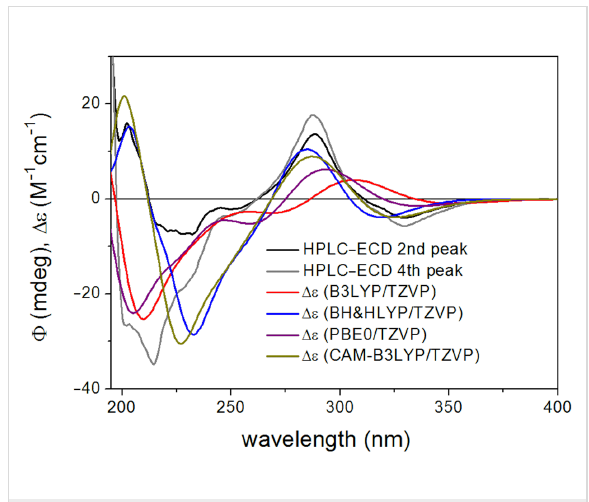
Figure 8: Experimental HPLC–ECD spectra of (2 R ,5’’ S )- 2a and (2 R ,5’’ R )- 2d compared with the Boltzmann-weighted ECD spectra computed for the CAM-B3LYP/TZVP PCM/MeCN low-energy conformers of (2 R ,5’’ S )- 2 at various